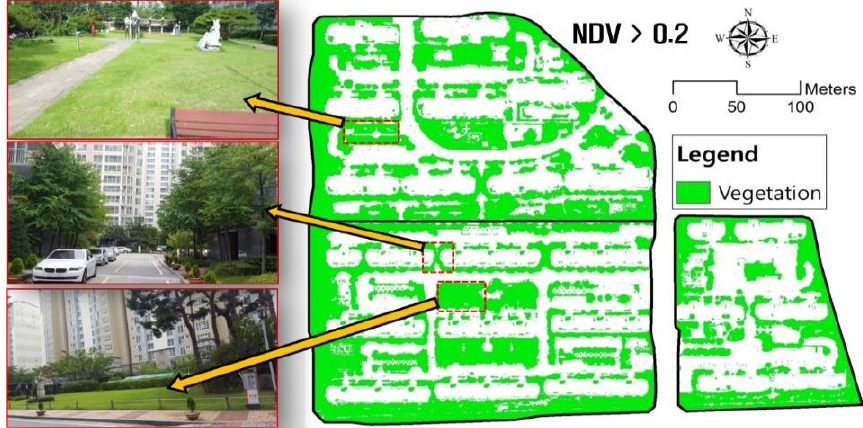
Figure 12. Vegetation map classified by applying NDVI around trees and grass lands.